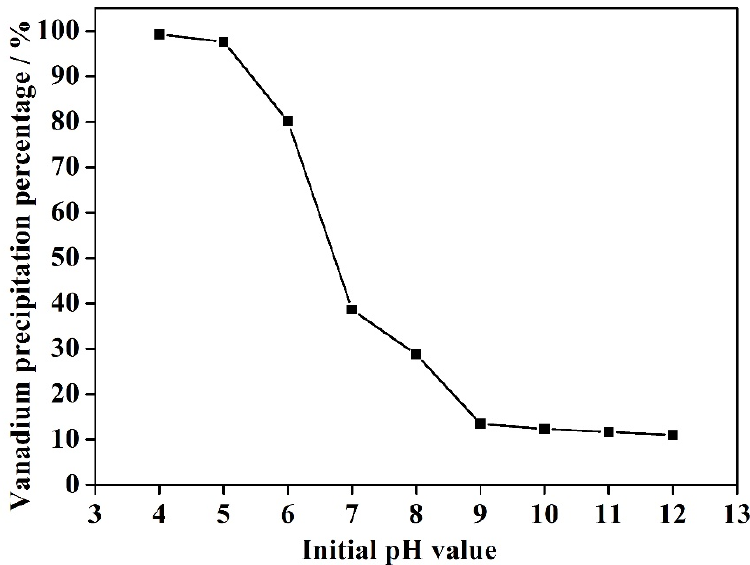
Figure 2. The effect of initial solution pH value on vanadium precipitation percentage. Figure 2. The e ff ect of initial solution pH value on vanadium precipitation